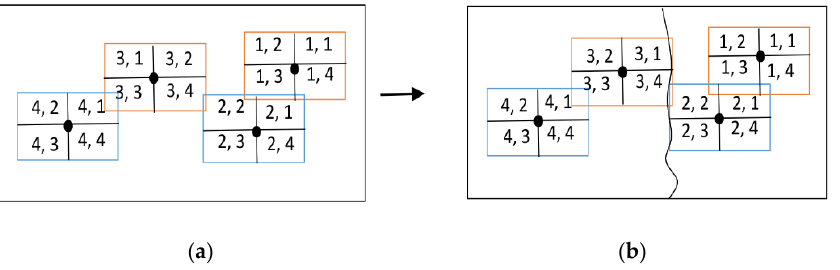
Figure 4. The illustration of map segmentation: ( a ) presents the input map without map segmentation; ( b ) presents that the input map is divided into two segments.